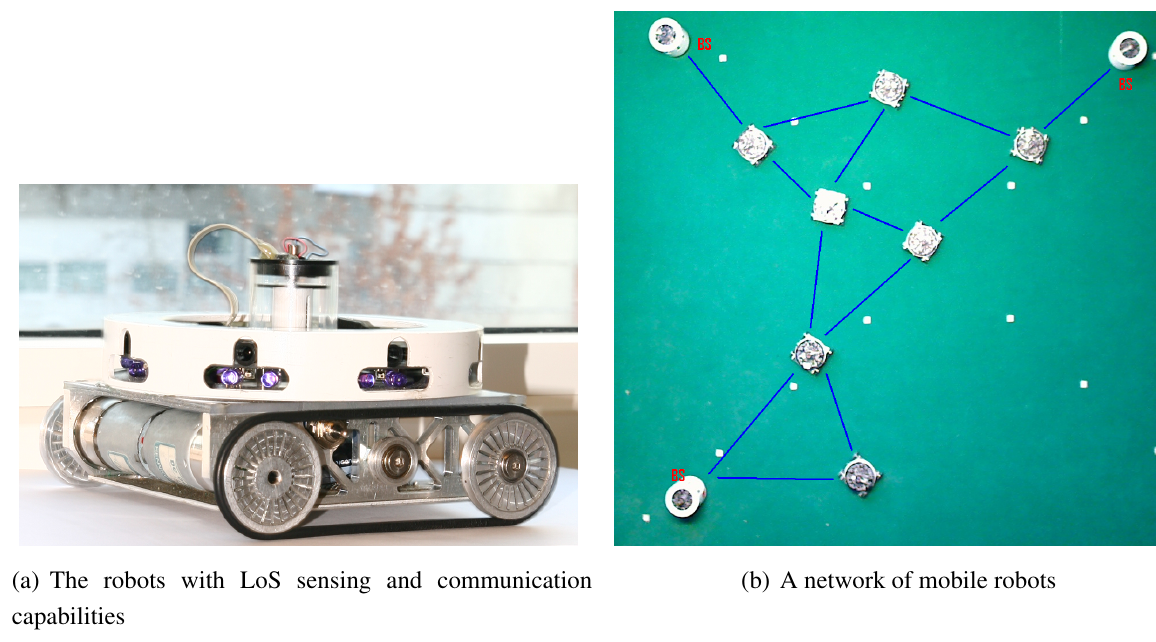
Figure 1. An example of the real robots and their network that needs to optimize the link